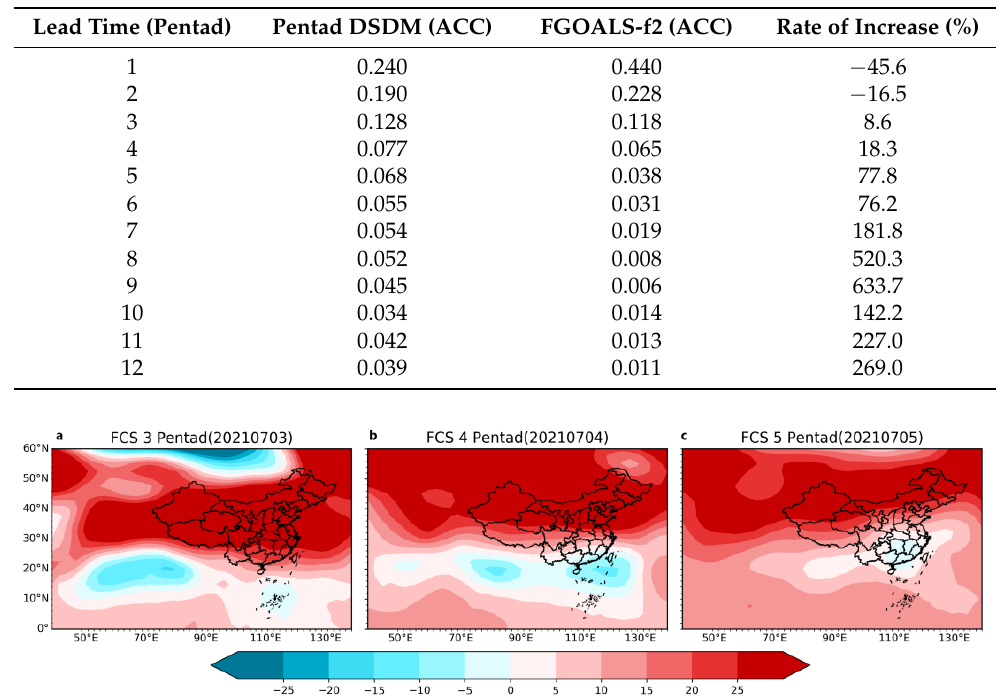
Table A1. ACC scores for each leading pentad over China (the rate of increase was calculated using Equation (A1)).